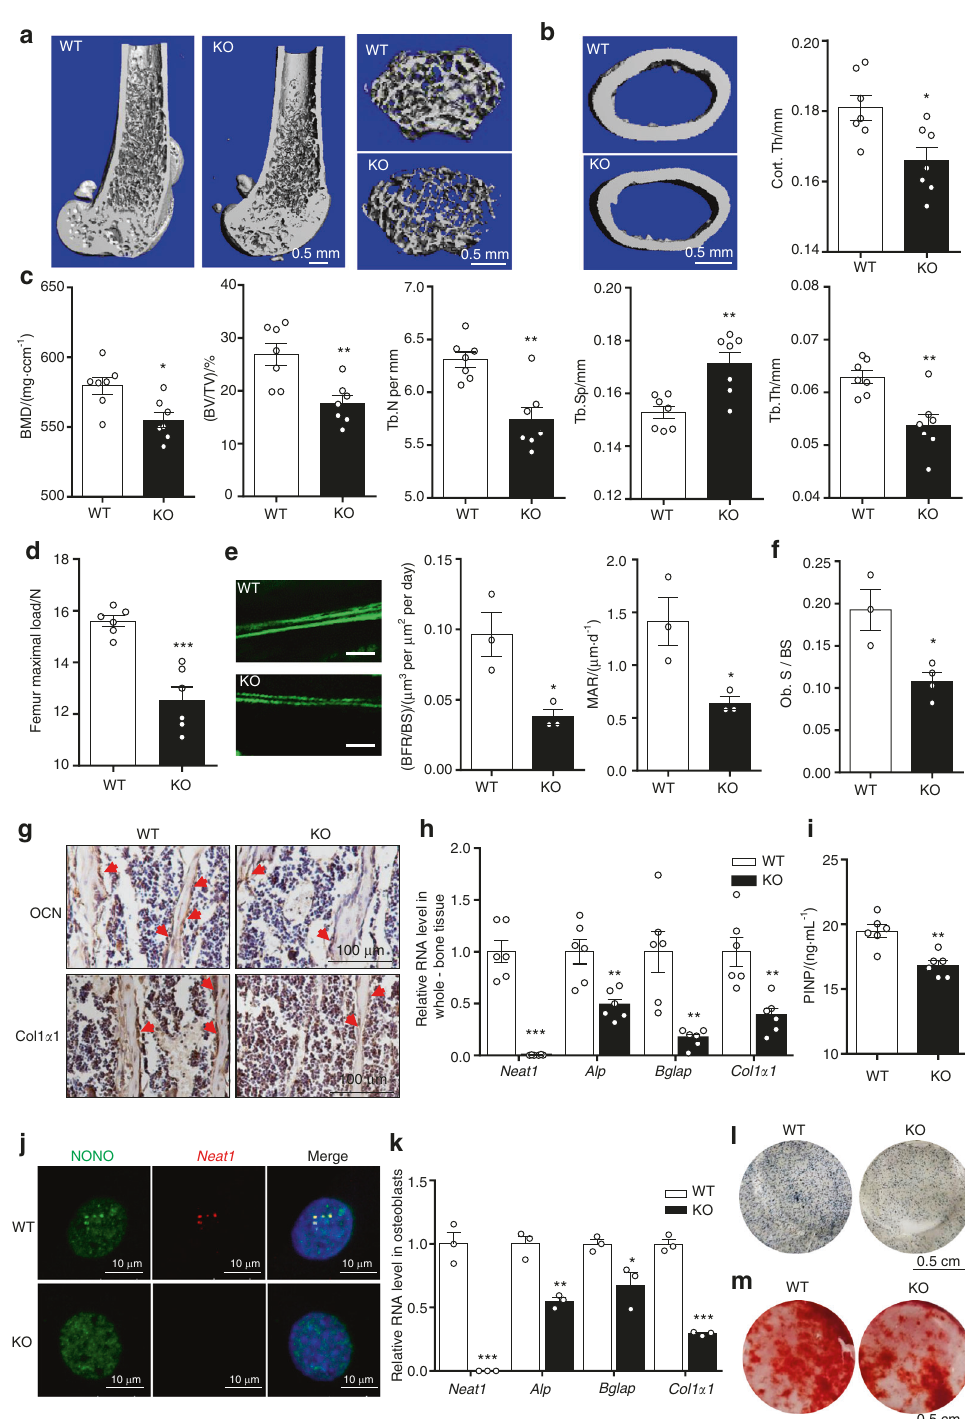
Fig. 3 Neat1 de fi ciency resulted in reduced bone formation and impaired osteoblast function. a , b Representative trabecular and cortical bone 3D μ -CT images from distal femurs of 2-month-old WT and Neat1 -KO male mice. Scale bars, 0.5 mm. Cortical bone thickness of distal femurs from the WT ( n = 7) and Neat1 -KO ( n = 7) mice was analyzed. c Quantitative µ-CT analysis of BMD, BV/TV, Tb.N, Tb.Sp and Tb.Th from the WT ( n = 7) and Neat1 -KO mice ( n = 7). d Femur maximal load determined by three-point bending in the WT ( n = 6) and Neat1 -KO ( n = 6) mice. e Double calcein labeling images showing new bone formation from the WT ( n = 3) and Neat1 -KO ( n = 3) mice. BFR/BS, bone formation rate/ bone surface. MAR, mineral apposition rate. Scale bars, 50 μ m. f Histomorphometric analysis of osteoblast surface per bone surface in the WT and Neat1 -KO mice. n = 3 in each group. g Immunohistochemical staining of OCN and Col1 α 1 in tibial sections from 6-week-old Neat1 -KO ( n = 3) mice and WT ( n = 3) mice. Scale bars, 100 μ m. h Analysis of osteogenic marker gene expression in bone tissue from the WT ( n = 6) and Neat1 - KO ( n = 6) mice. i ELISA analysis of serum PINP (ng·mL − 1 ) in 2-month-old WT ( n = 6) and Neat1 -KO ( n = 6) mice. j Representative FISH images of paraspeckles in the WT and Neat1 -KO osteoblasts. Scale bars, 10 μ m. k Analysis of osteogenic marker genes in primary osteoblasts isolated from the WT and Neat1 -KO mice. n = 3 in each group. l ALP staining images of the WT and Neat1 -KO osteoblasts induced with osteogenic medium for 3 days. m. Representative Alizarin red staining images of the WT and Neat1 -KO osteoblasts. * P < 0.05, ** P < 0.01, *** P <